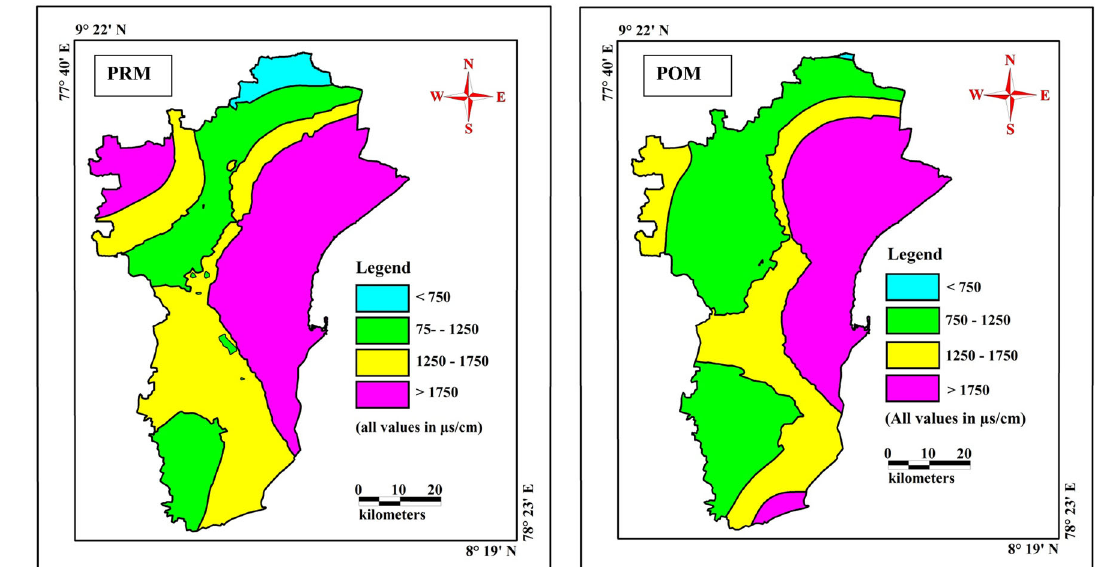
Fig. 5 Spatial distribution of EC in the study area during PRM and POM (all values in mg l - 1